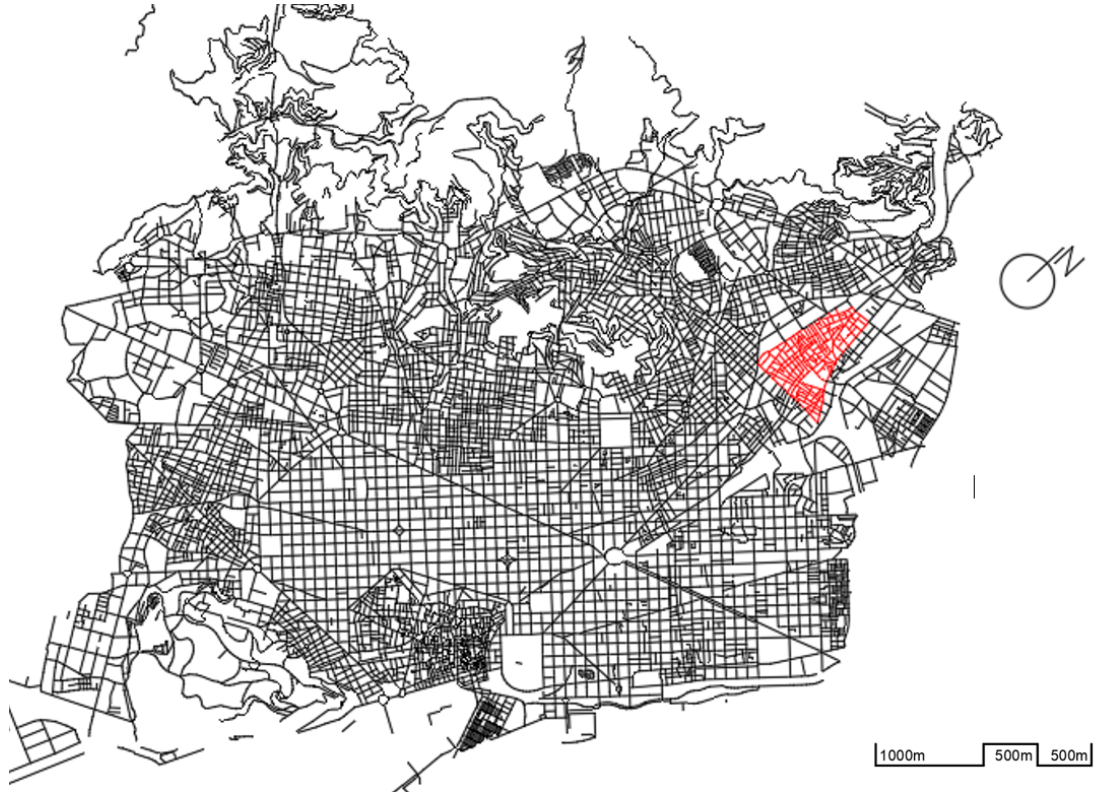
Figure 1. Location of Sant Andreu del Palomar in Barcelona City.